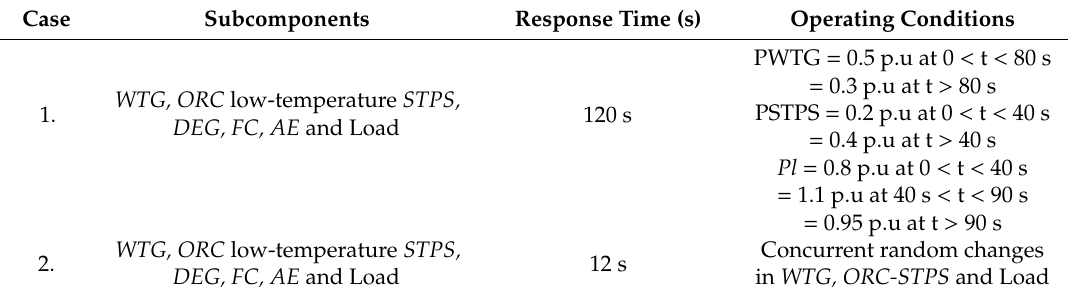
Table 3. Di ff erent simulated cases